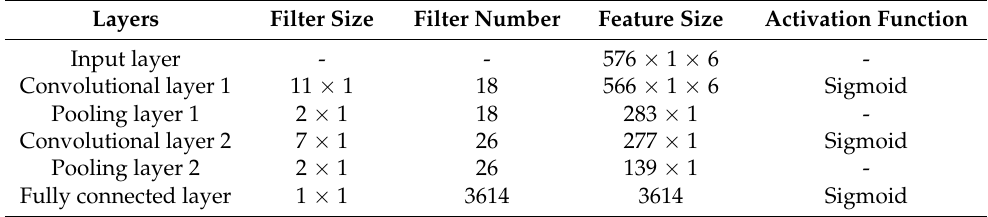
Table 4. The structural parameters of 1DCNN.